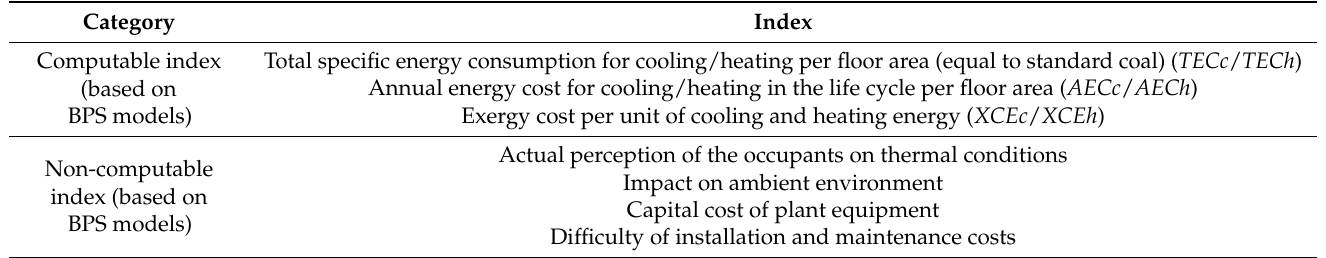
Table 1. Classification of all indices in this